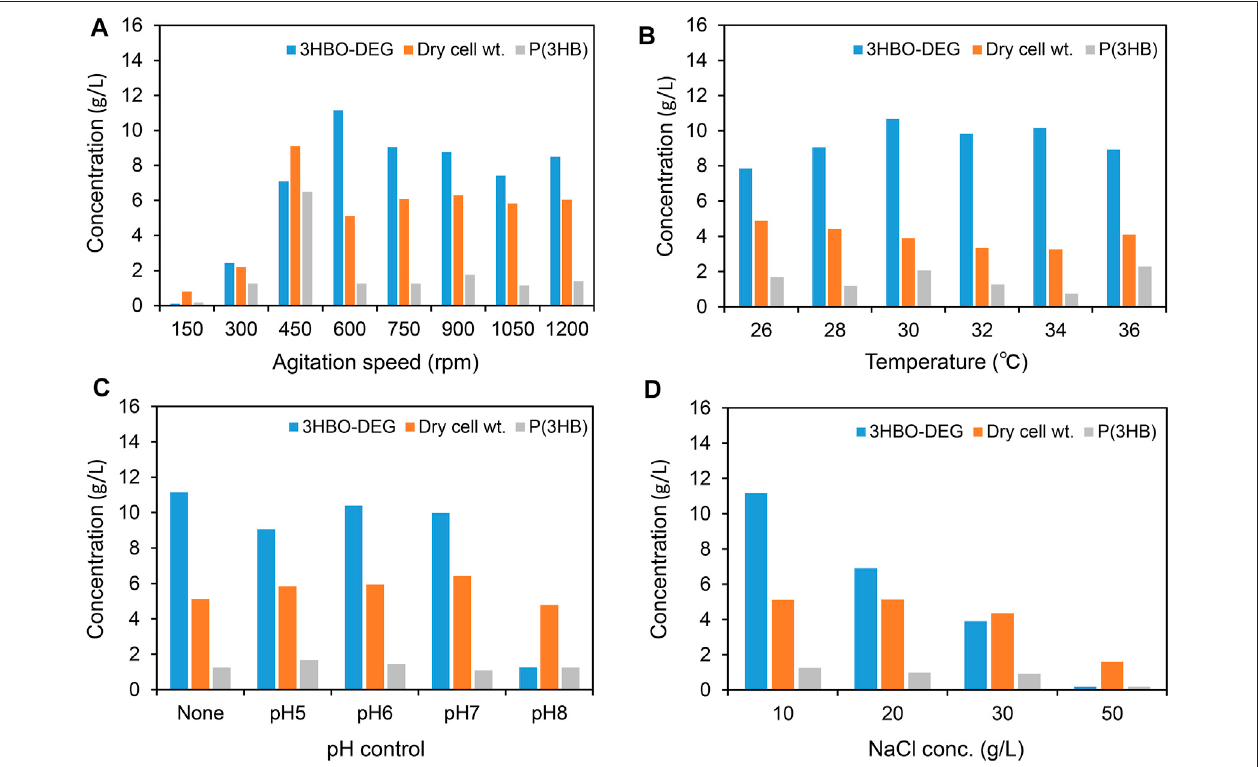
FIGURE2| Batch culturesofrecombinant E.coli BW25113 Δ adhE harboringpGEM- phaRC YB4 AB witha250-mlminijarfermenter.Cellswerecultured ina100 ml LB medium supplemented with 40 g/L glucose and 50 g/L DEG for 48 h [except for (B) , 96 h]. The effects of the (A) agitation speed, (B) culture temperature, (C) pH control (pH was regulated automatically by adding 1 N NaOH or 1 N HCl for pH-stat culture), and (D) NaCl concentration on 3HBO-DEG secretion were examined. Unless otherwise indicated, culture conditions were 600 rpm, 1 vvm, 30 ° C, pH uncontrolled, and 10 g/L